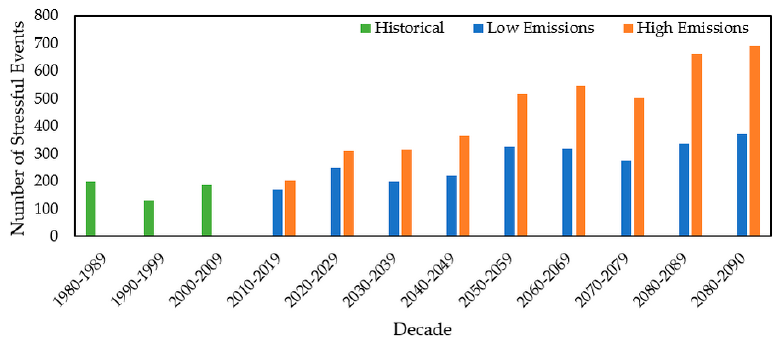
Figure 12. Number of stressful events predicted in the Beaver River watershed between 1980 and 2099 under historical conditions, low CO 2 emissions and high CO 2 emission scenarios.